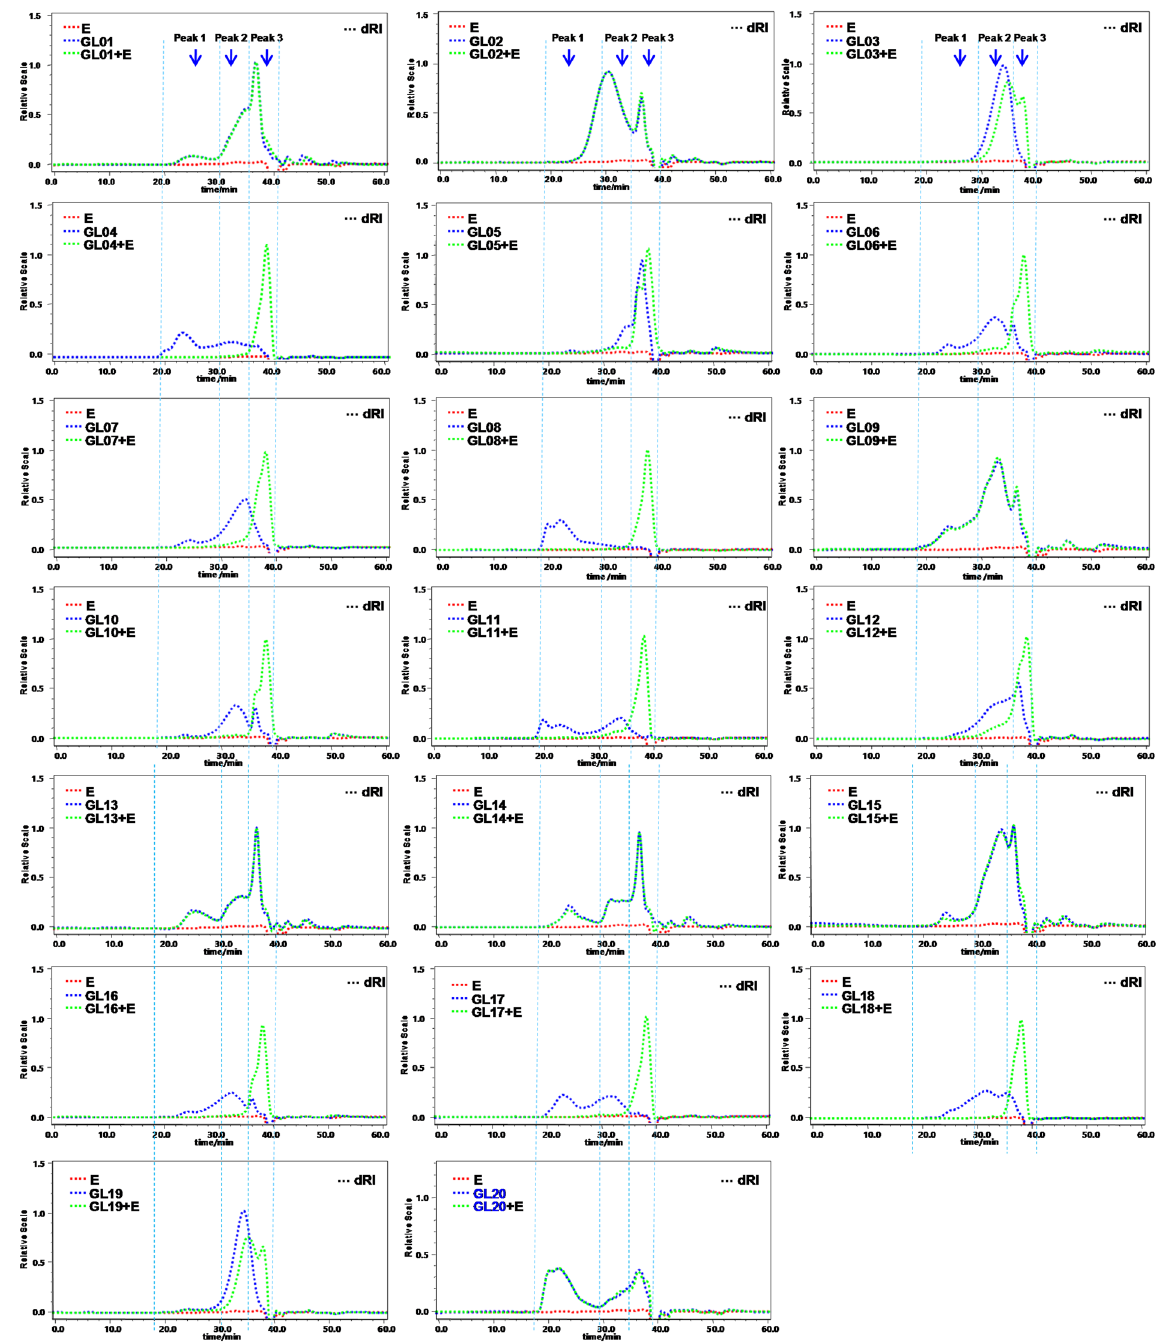
Figure 6. HPSEC chromatograms of polysaccharides in G . lucidum dietary supplements before and after α -amylase digestion. E , α -amylase; GL and GL + E , polysaccharides without and with α -amylase digestion, respectively. Sample codes were the same as in Table